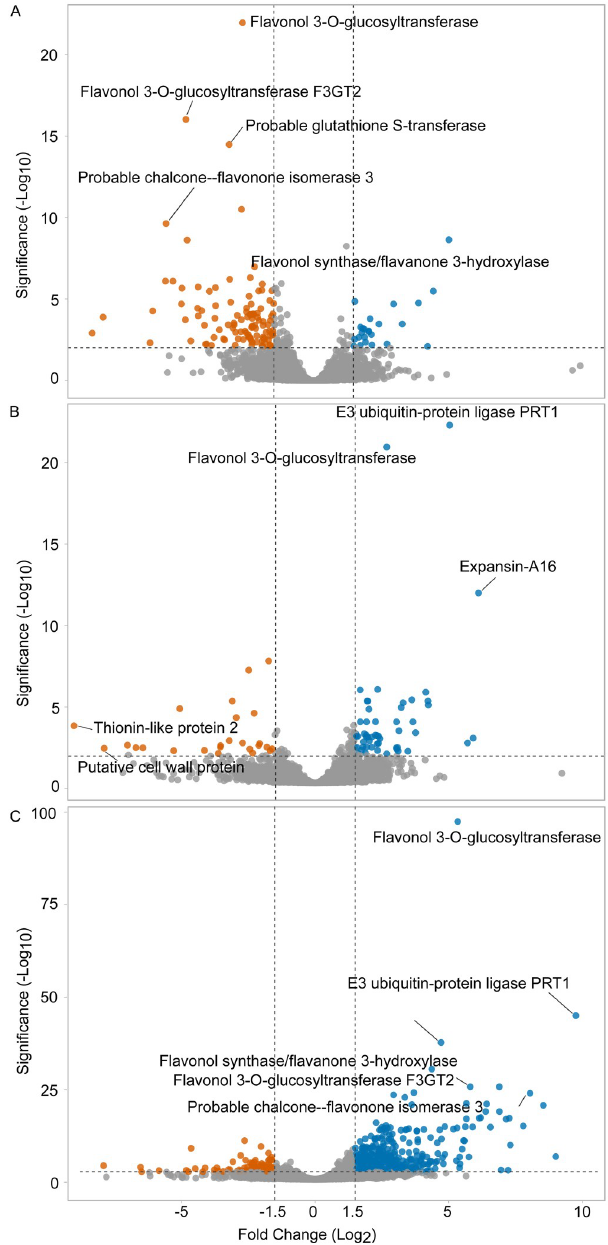
Fig 1. Volcano plot of RNA-Seq data. Scatter plots show the log2 of fold change and significant levels of genes from the expression comparison between (A) the R-treated and the W-treated C . asiatica , (B) the B-treated and the W- treated C . asiatica , and (C) the B-treated and the R-treated C . asiatica . The grey dots show insignificant DEGs (|log2 of fold change| < 1.5 and/or FDR > 0.05). Blue dots show genes of the R-treated or the B-treated C . asiatica with a higher expression level than that of the references (the W-treated in panel A and B, and the B-treated in panel C). Orange dots show genes of the R-treated or the B-treated C . asiatica with a lower expression level than that of the references.